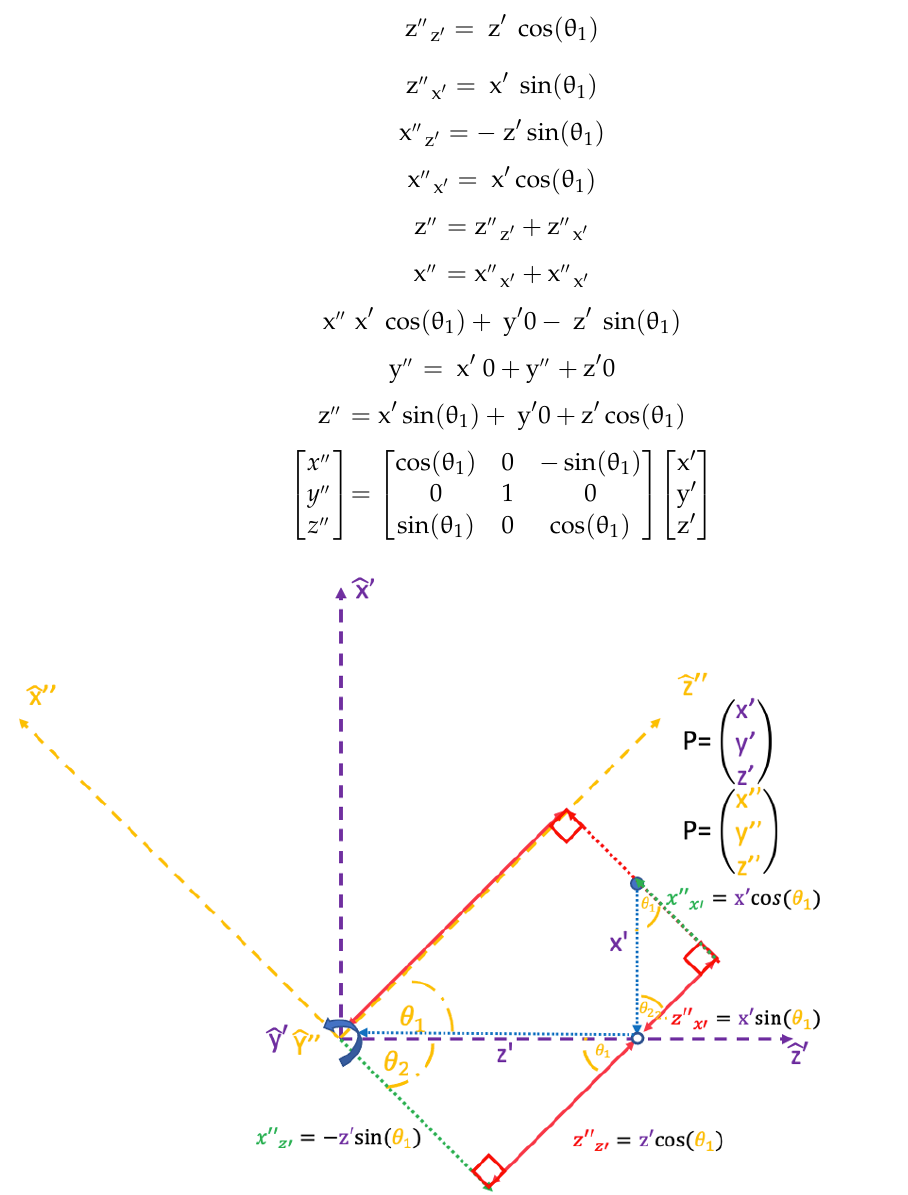
Figure 16. 2-rotation about the ˆ y (cid:48) and ˆ y (cid:48)(cid:48) axes to develop P’s coordinates in the new reference frame with all similar angles, shapes, and equations established in Figures 7 – 15. Table 4. Proximal variable and nomenclature definitions for Figure 16.